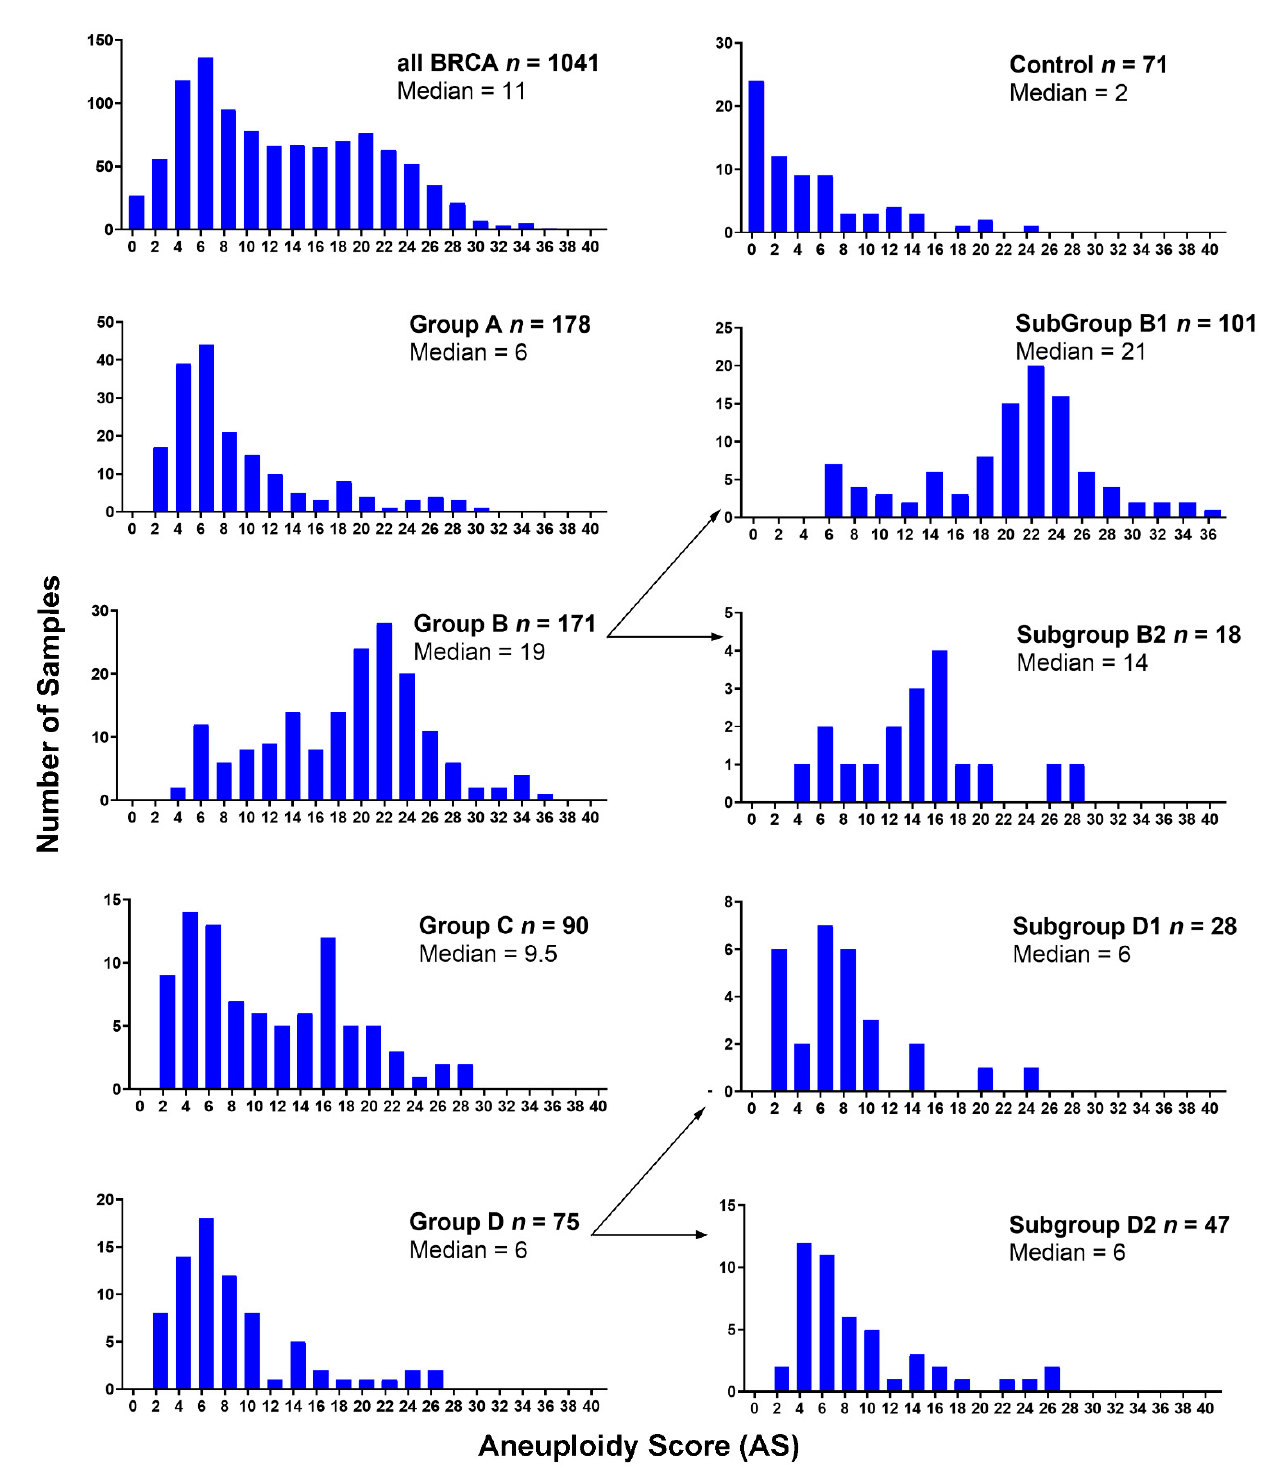
Figure 4. Distribution of the aneuploidy score (AS) for all BRCA samples and for each 1,16-chromogroup. Number of samples ( y -axis) for different AS values ( x -axis; bin equal to two) are shown. The total number of samples ( n ) and the median AS in each group is reported in the corresponding graph.